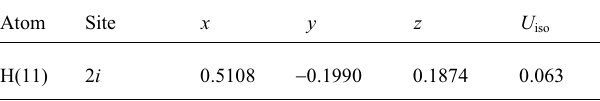
Table 2. Atomic coordinates and displacement parameters (in Å 2 ) .